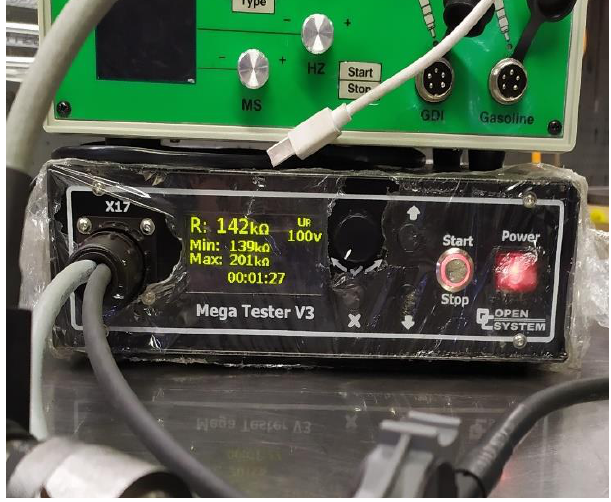
Fig. 5. Negative result of the measurement in the continuous load